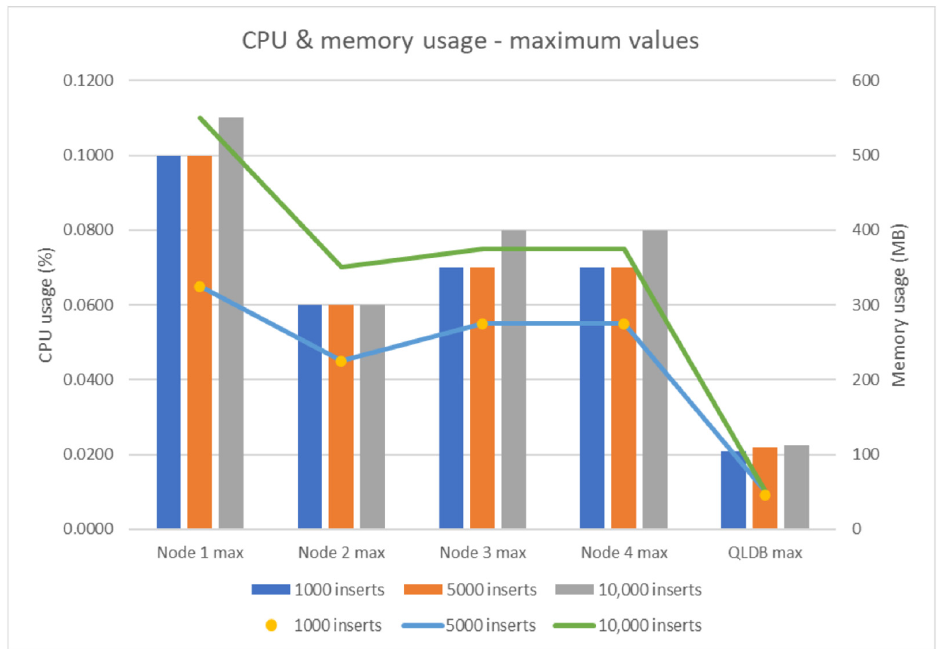
Figure 33. CPU and memory usage—maximum values.